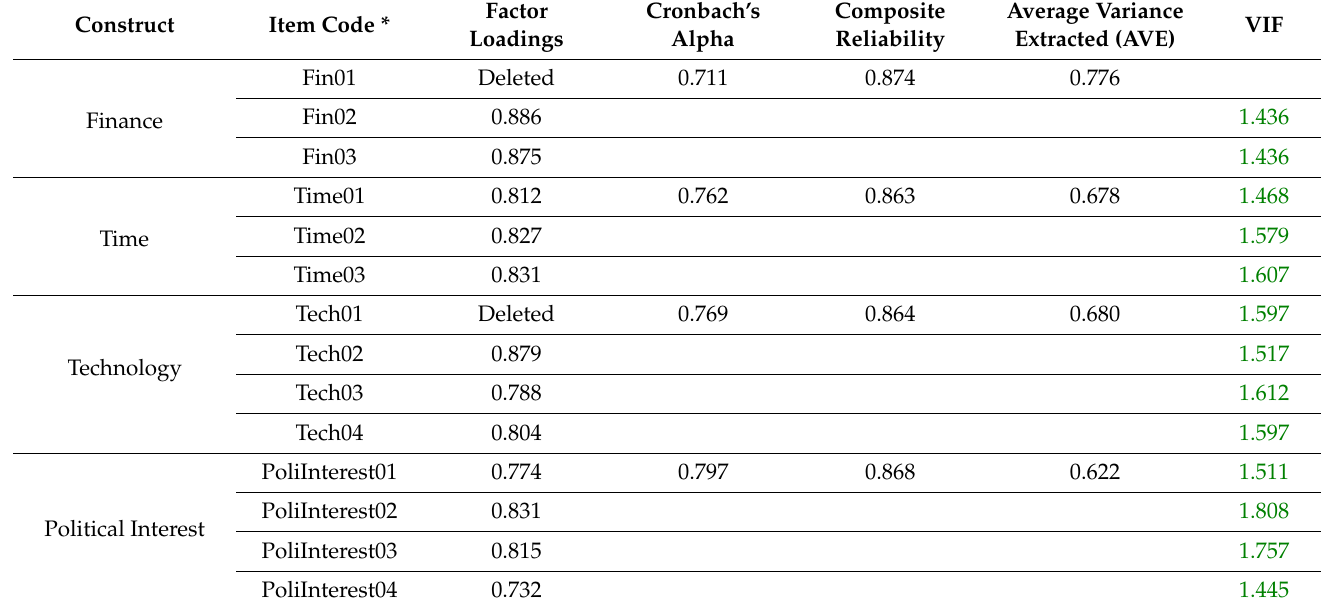
Table 1. Measurement